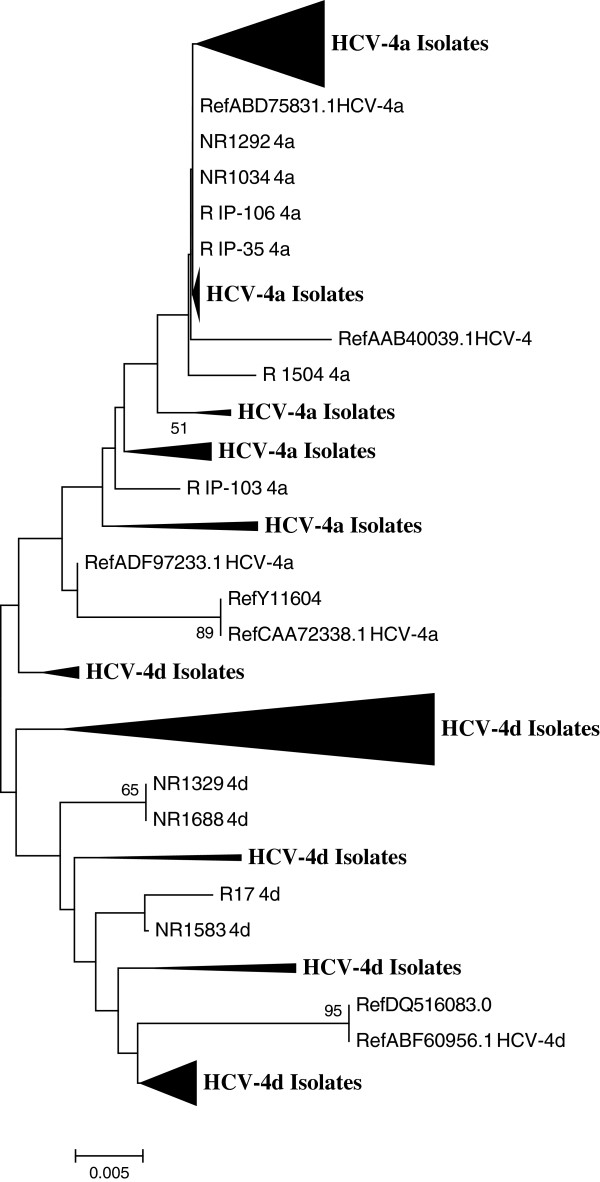
Phylogenetic tree constructed from sequences of the HCV-4 core protein using neighbor-joining algorithm method. Bootstrap values corresponding to 1000 replications are indicated below the branches and only bootstrap values > 50% were included. Elongated triangles represent the compressed subtrees with captions indicating HCV isolates and references. The thickness of the triangles is proportional to the number of taxa included and the length of the triangle corresponds to the respective diversity.